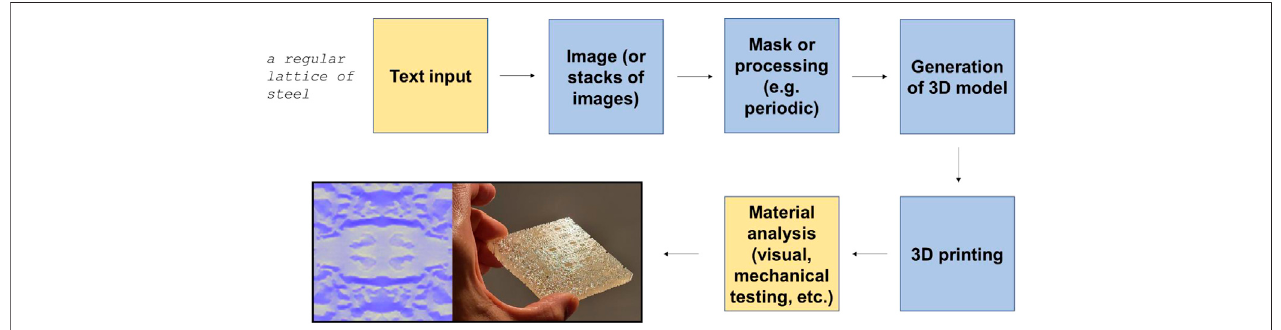
FIGURE 1 | Flowchart of research reported here, translating words to 3D material designs, which can be realized using additive manufacturing, and further analyzed using experimental testing and/or modeling (e.g., to compute stress and strain fi elds).